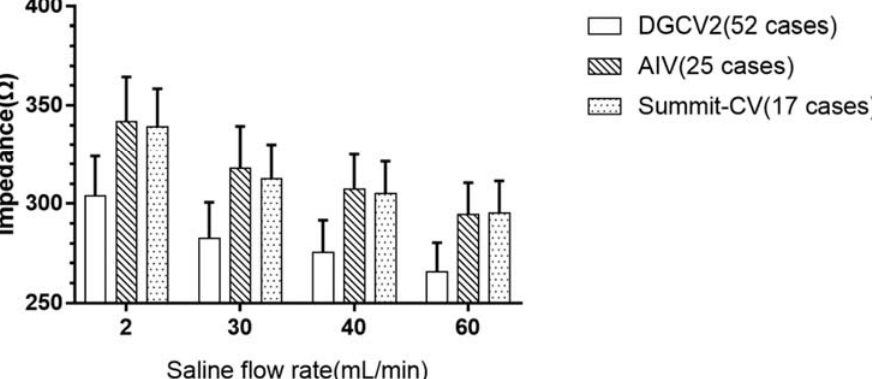
Figure 2. The impedance in different parts of the TAODGCV. The above impedance values were measured at the initial state (saline flow rate was 2 mL/min).